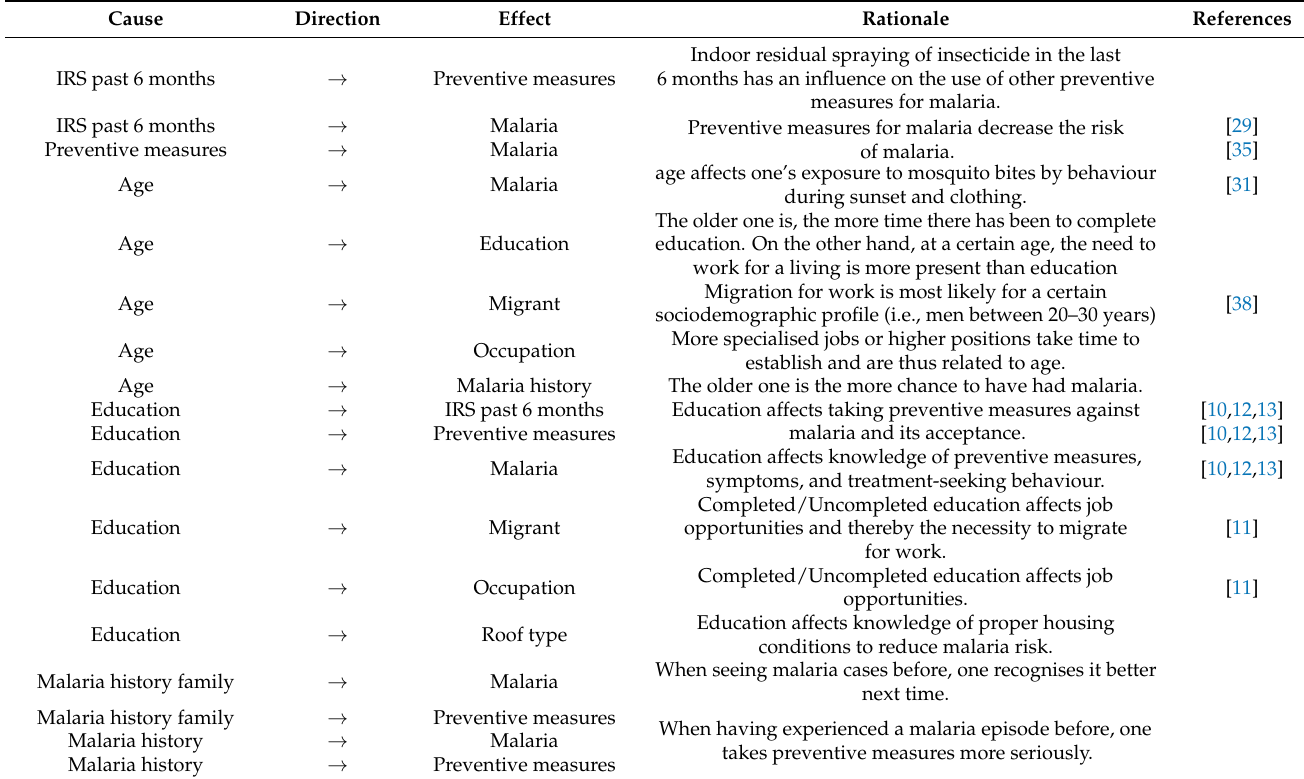
Figure A1. Directed acyclic graph (DAG) that was used to obtain the set of variables to adjust for in the models. Table A1. Assumptions in the causal paths of the Directed acyclic graph (DAG) with their rationale and references if available.